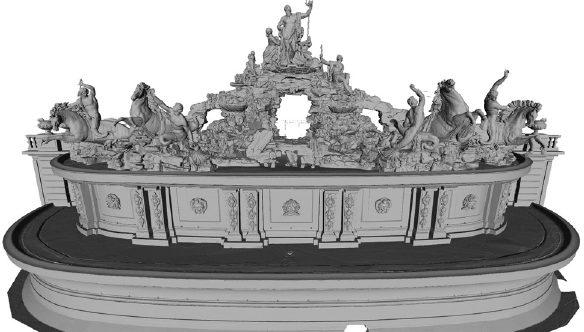
Figure 5. Triangulation of the cascade basins, the sculpture ensembles and the rocky grotto with Neptune on top of it.